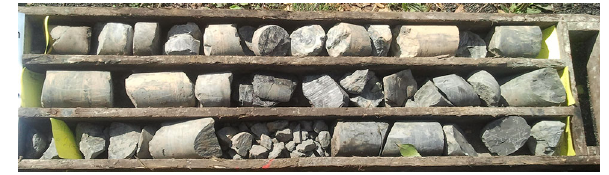
Fig. 1 Intensely crushed core from the floor of the work